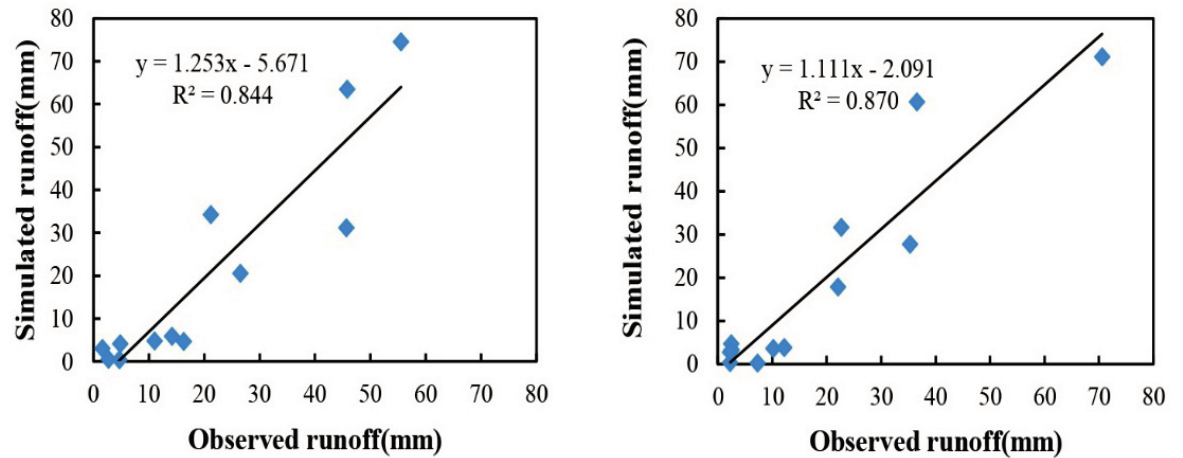
Figure 5. Comparison between observed and simulated monthly runoff at Site 2 ( left ) and Site 3 ( right ) during validation